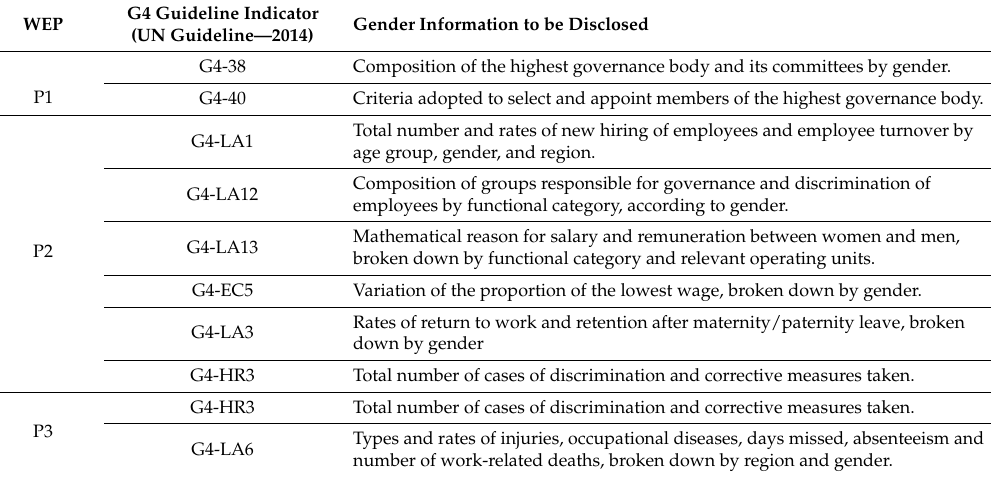
Alignment of Women’s Empowerment Principles (WEP) with the corporate social responsibility (CSR) indicators of the Global Reporting Initiative (GRI) guidelines.